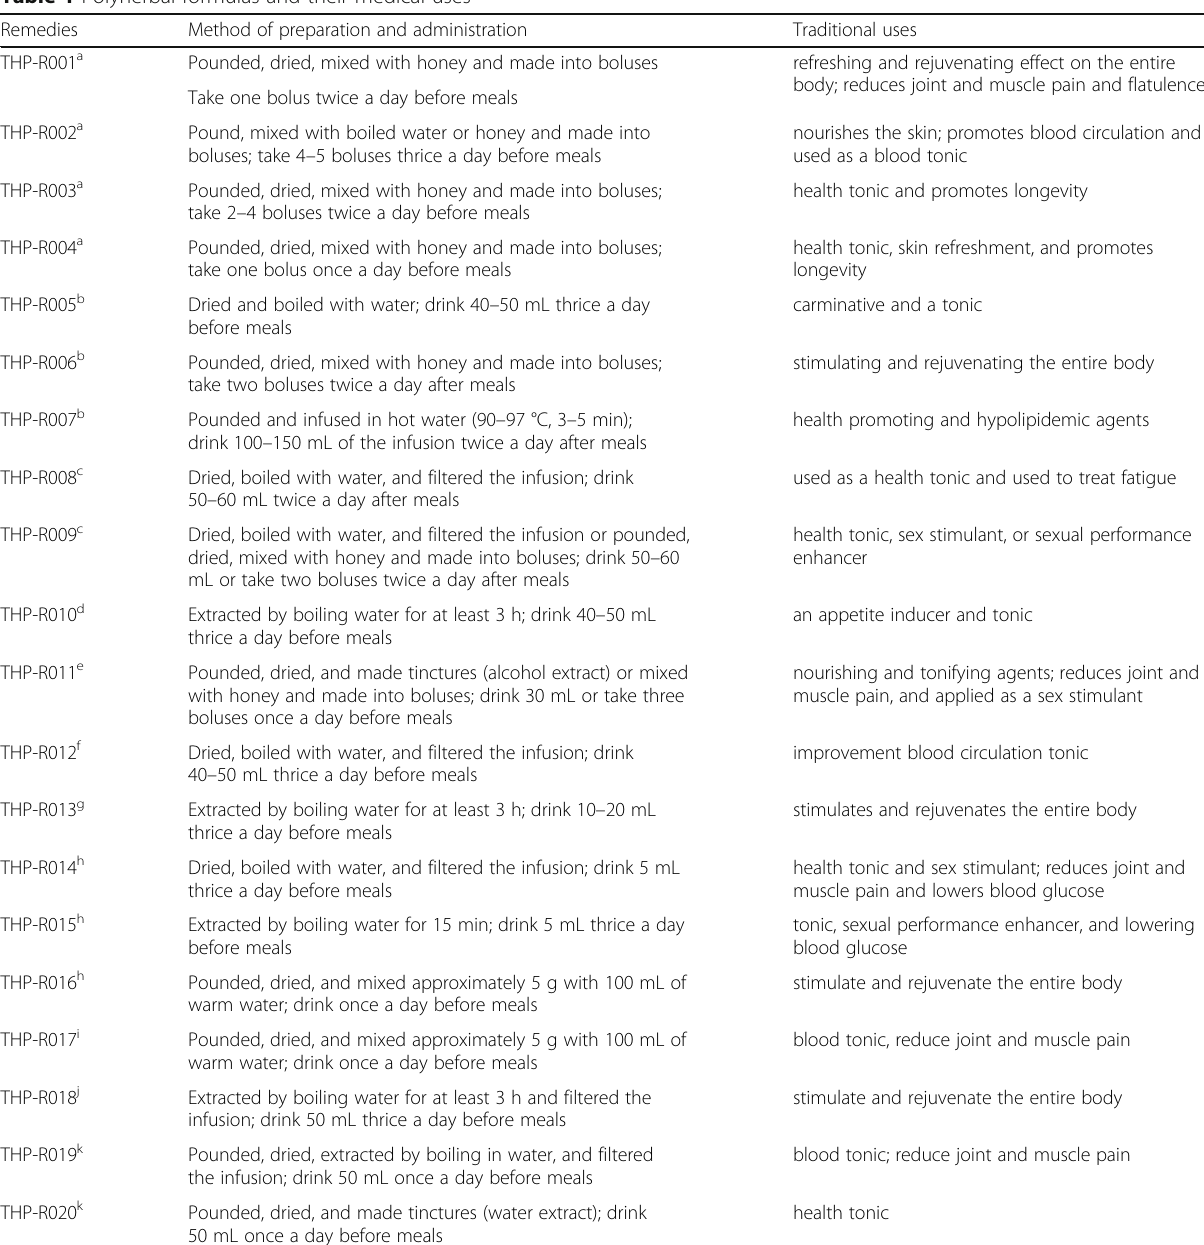
Table 1 Polyherbal formulas and their medical uses Remedies Method of preparation and administration Traditional uses Pounded, dried, mixed with honey and made into